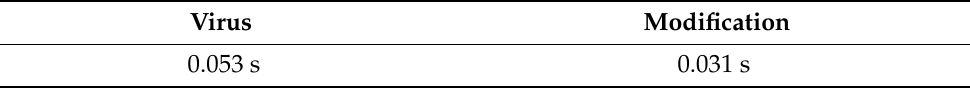
Table 6. Detection mean time.